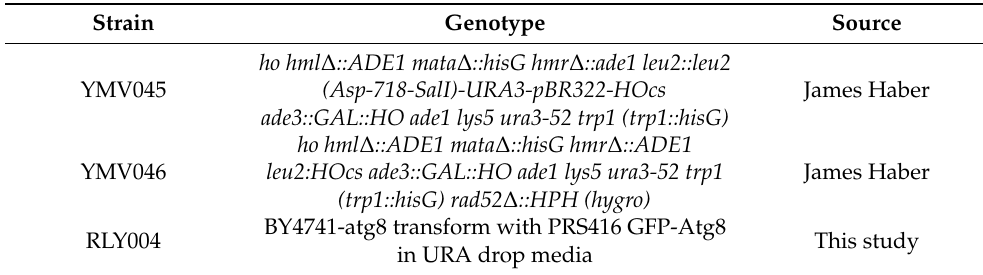
Table 1. Genotypes of yeast strains used in this study. Strain Genotype Source